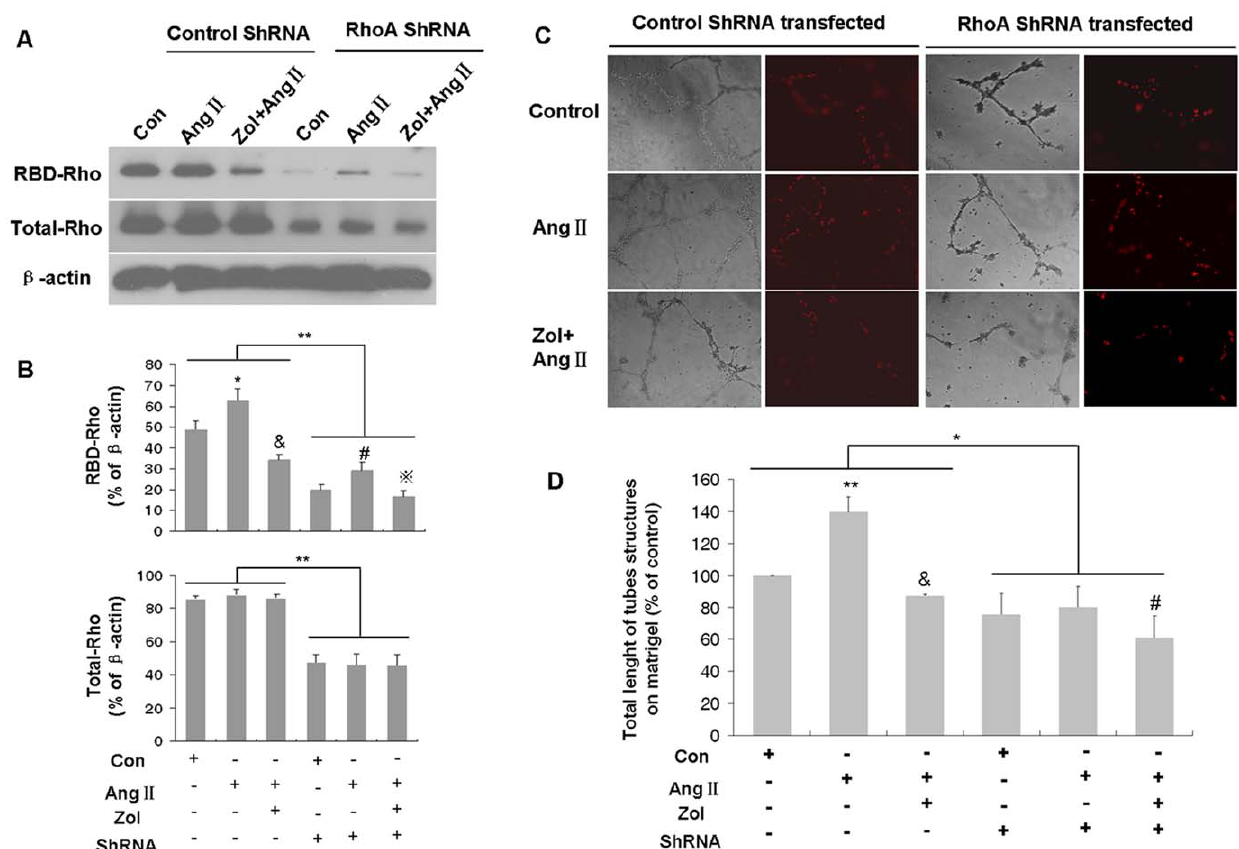
Figure 8. Involvement of ERK (A) and JNK (B) signaling in the effects of Zol on EPCs. Serum-starved EPCs in the absence or presence of 50 m M Zol were combined with or without 50 m M GGOH before incubation with 1 m M Ang II for 15 min. Phosphorylated Erk, total Erk, phosphorylated JNK, and total JNK proteins were detected by Western blot. Values shown are representative of three independent experiments. * P , 0.01 vs. control group; ** P , 0.01 vs. Ang II group; &P , 0.01 vs. Zol + Ang II group.